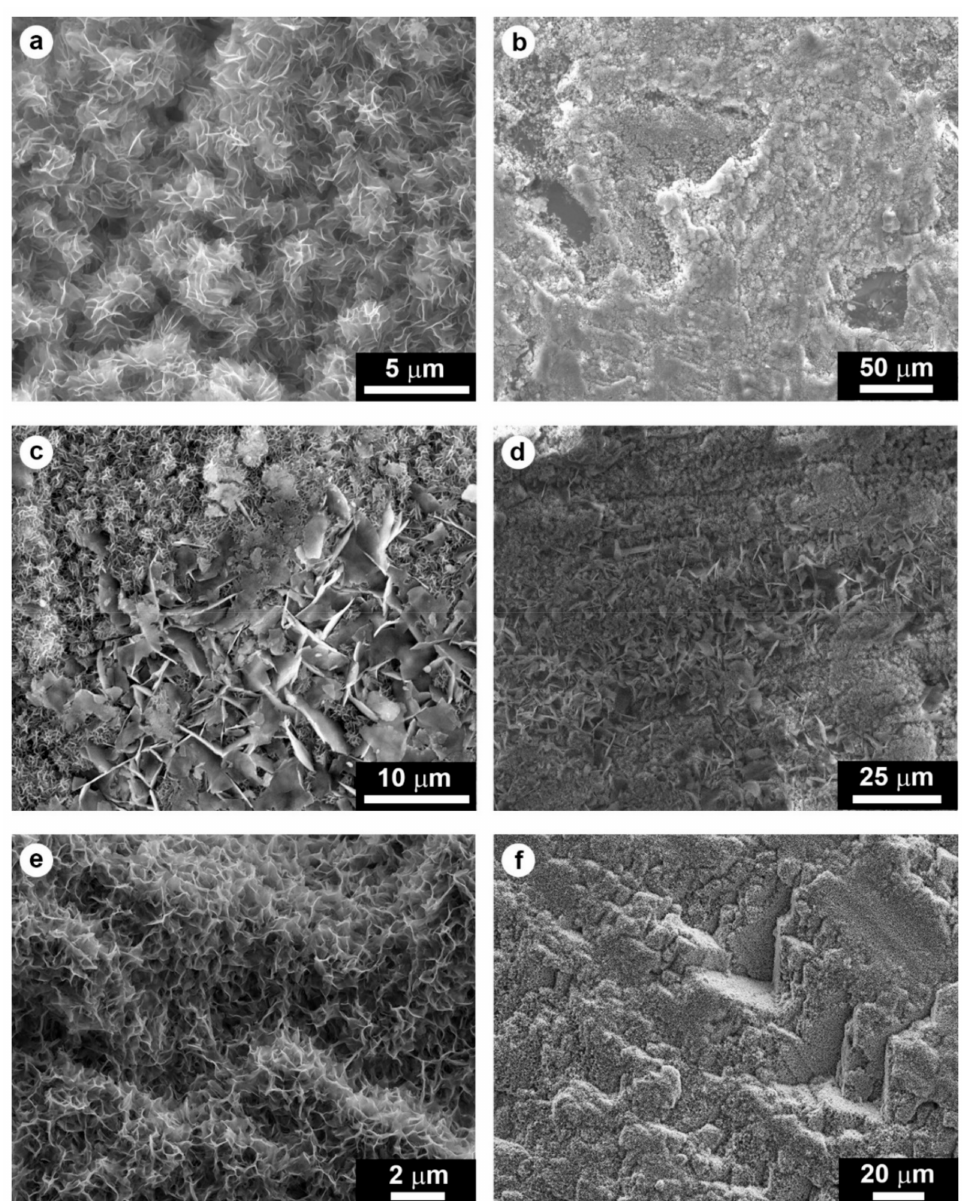
Figure 2. Scanning electron microscopy (SEM) images of CaP coatings with different compositions (determined by XRD): ( a , b ) HAP coating formed over Carrara marble after treatment with a 1 M DAP solution for 24 h; ( c , d ) HAP + octacalcium phosphate (OCP) coating formed over Carrara marble after treatment with a 1 M DAP + 1 mM CaCl 2 solution for 9 h ( c ) and 24 h ( d ) - by comparison with the morphology of the HAP coating illustrated in ( a , b ), the small flakes in ( c ) were identified as HAP and the large flakes as OCP [34]; ( e , f ) OCP coating formed over Carrara marble after treatment with a 0.1 M DAP + 1 mM CaCl 2 in 10 vol % ethanol solution for 24 h. Images ( a – d ) adapted from reference [34] with permission from